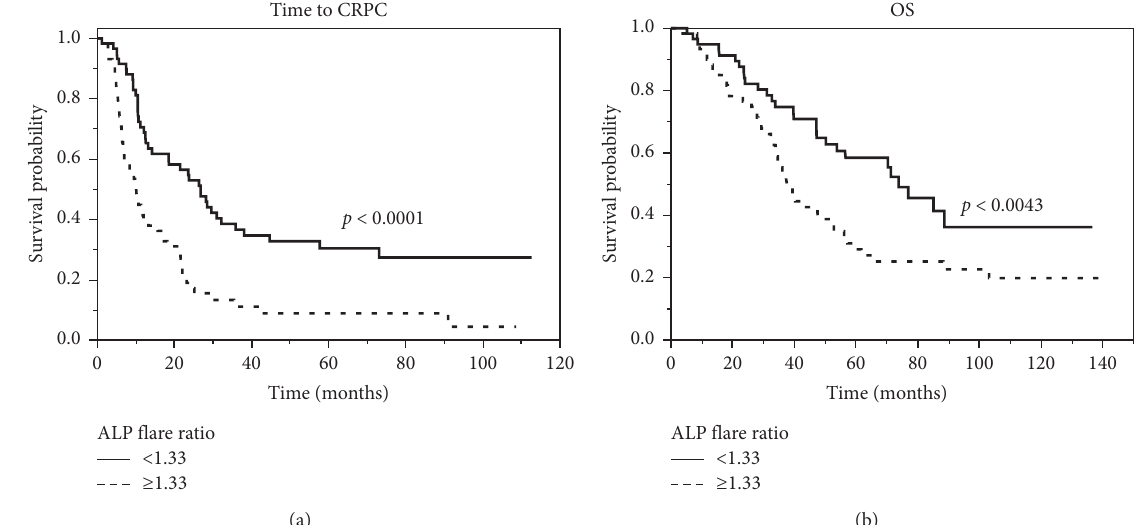
Figure 2: Kaplan–Meier curves showing time to castration-resistant prostate cancer (CRPC) (a) and overall survival (OS) (b) according to an ALP flare ratio less than 1.33 or 1.33 or